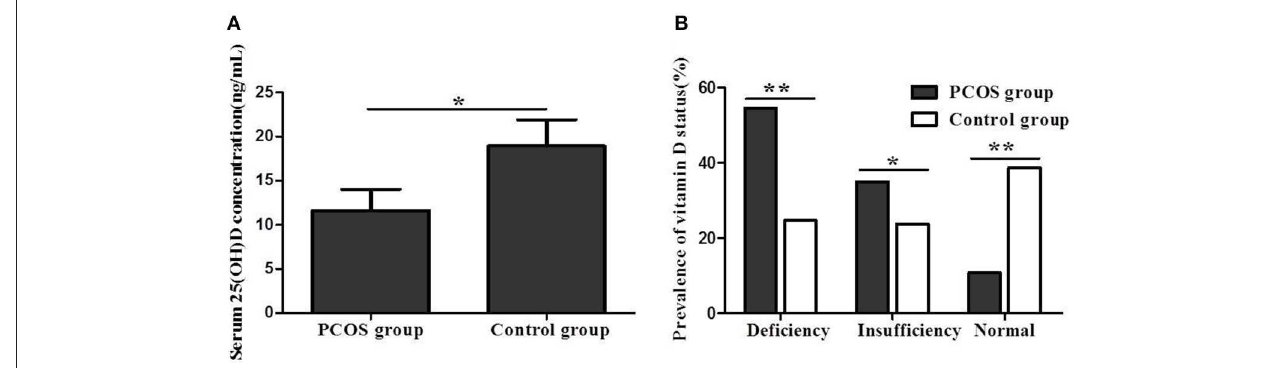
FIGURE 1 | (A) Serum 25(OH)D concentration between women with PCOS and control group. (B) Vitamin D status between women with PCOS and control group (* P < 0.05, ** P < 0.01).